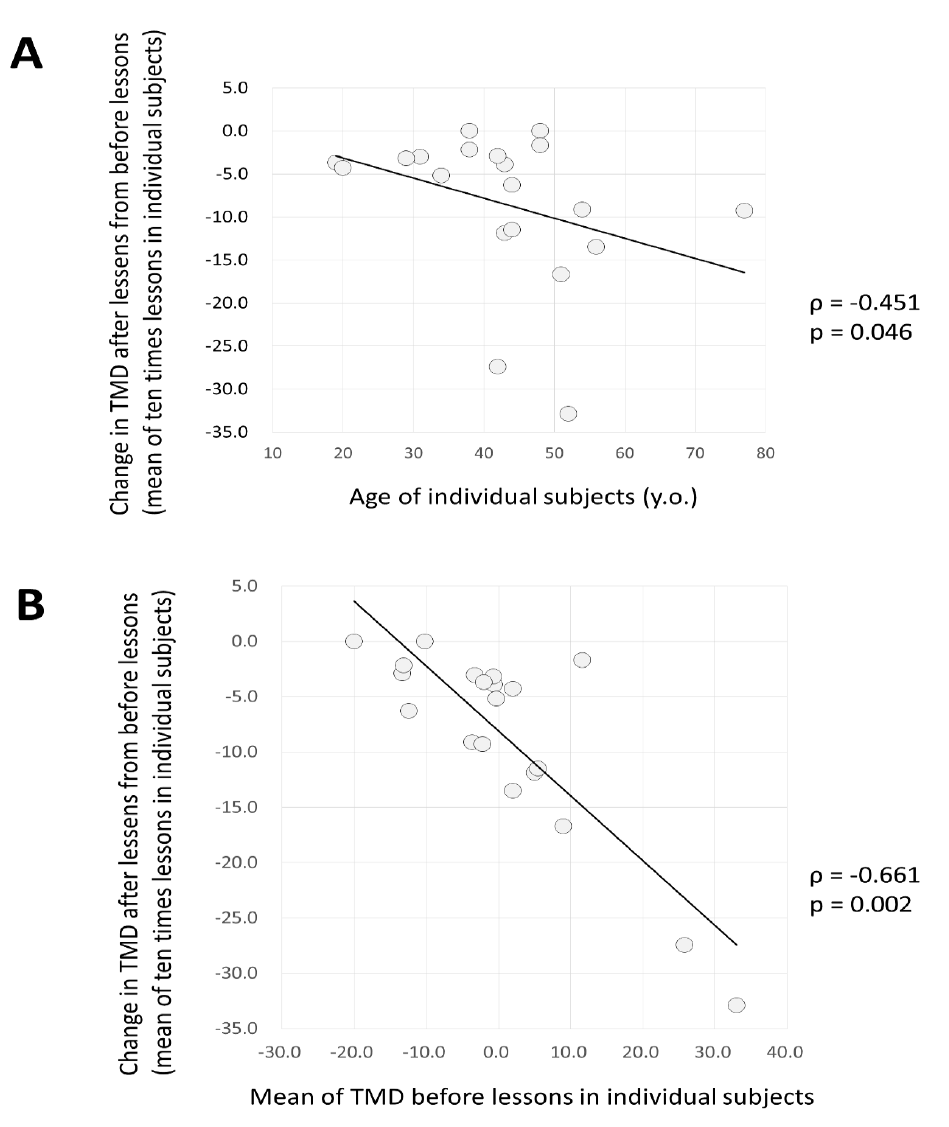
Figure 6. The relationship between the change in TMD (before and after the lesson) and the age, and the TMD before the lesson. ( A ) Relationship between the change in TMD before and after 10 lessons in the 20 subjects (post-value minus pre-value) and age. Results showed a significant negative correlation. ( B ) Relationship between change in TMD before and after 10 lessons in the 20 subjects (post-value minus pre-value) and TMD values of pre-lessons. This showed a significant negative